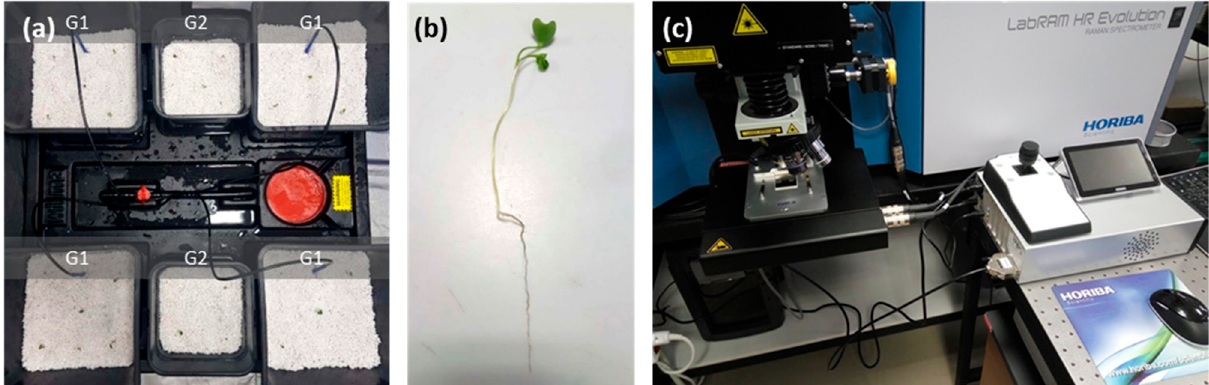
Figure 2. Experimental setup for the spectroscopic detection of ABS in radish roots: ( a ) Hydroponic cultivation of radish plants. ( b ) Treated sample before sectioning and microscopic observation. ( c ) LabRAM HR Raman Spectrometer confocal Raman microscope.